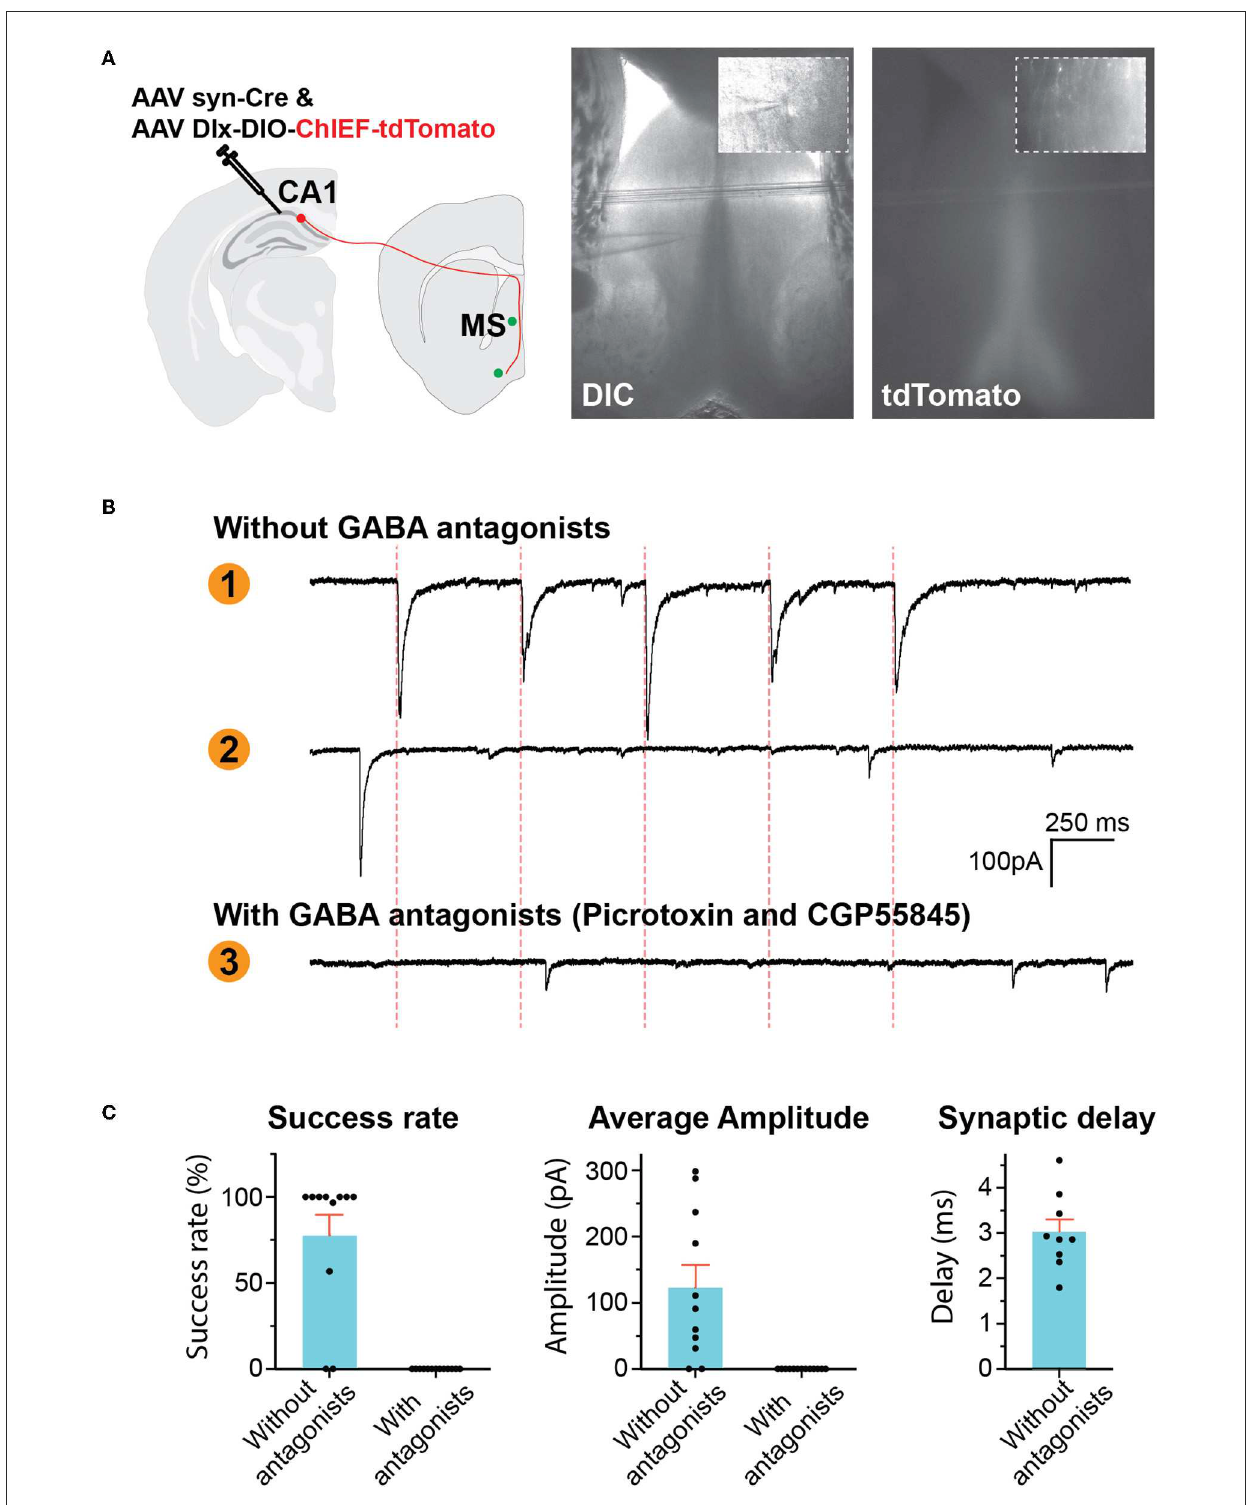
FIGURE2 GABAergic hippocampus–septum projections. (A) AAV injection scheme (left). Representative photos of brain slice (right) showing the location of tdTomato-positive axons in the MS and the location of whole-cell patch-clamp recording. The inserts are high-resolution images of the location of the pipette tip. (B) Representative traces of voltage-clamp recording of postsynaptic currents (PSCs). Traces 1 and 2 were recorded in the absence of GABA antagonists, showing a neuron reacting to optical stimulation (Trace 1) and another neuron not responding (Trace 2). Trace 3 was recorded in the presence of picrotoxin and CGP55845. The red dashed lines indicate the time of optical stimuli. (C) Quantification of the